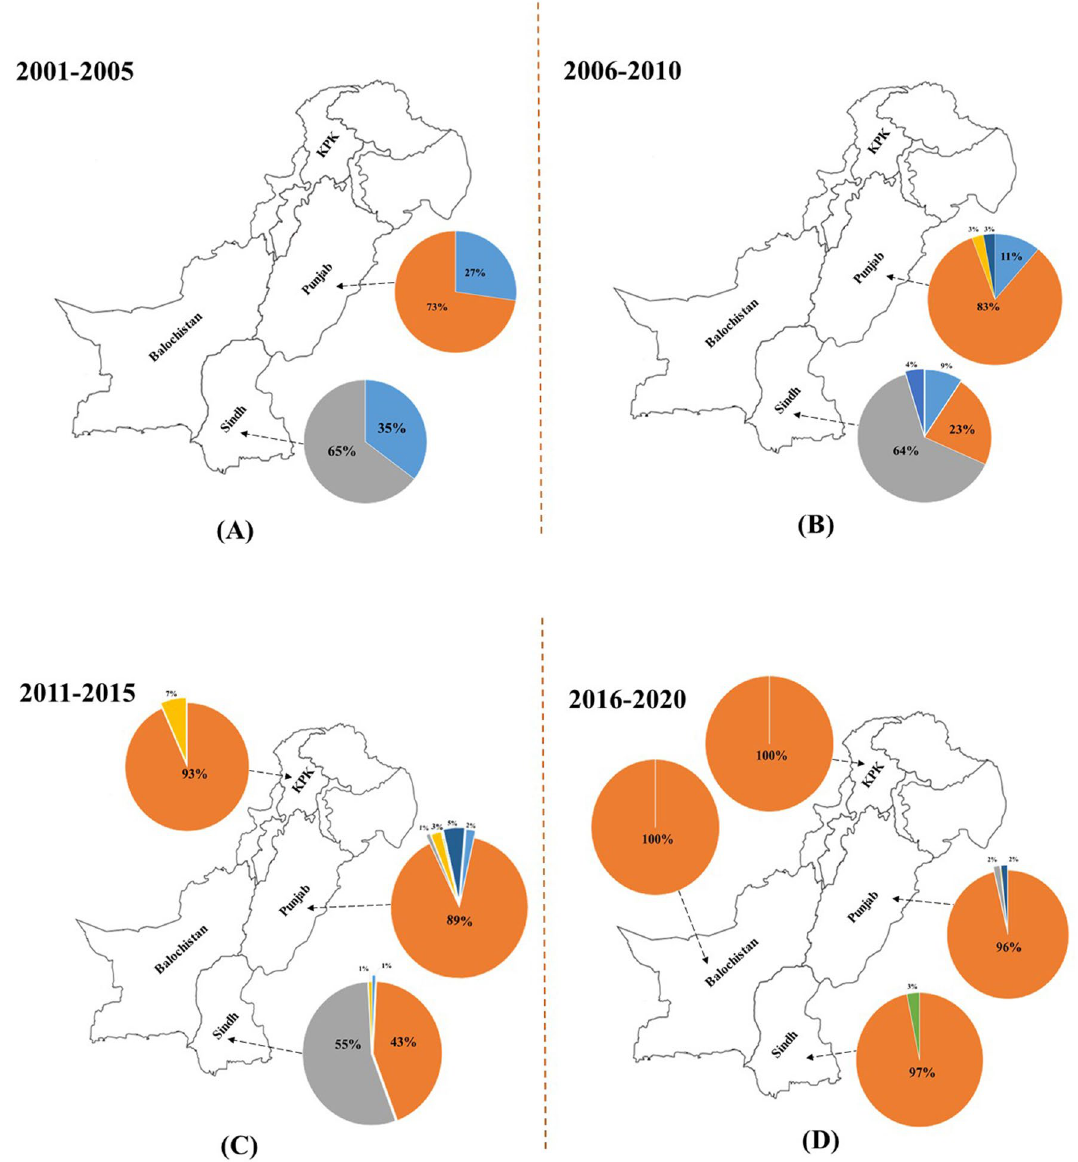
Figure 5. Relative % age of each species was determined with the timeline (an interval of five years). The relative % age of different species of B. tabaci reported from 2001 to 2005, 2006–2010, 2011–2015 and 2016– 2020. The map was generated using CorelDRAW 12 software and edited in Paint 3D and Microsoft PowerPoint